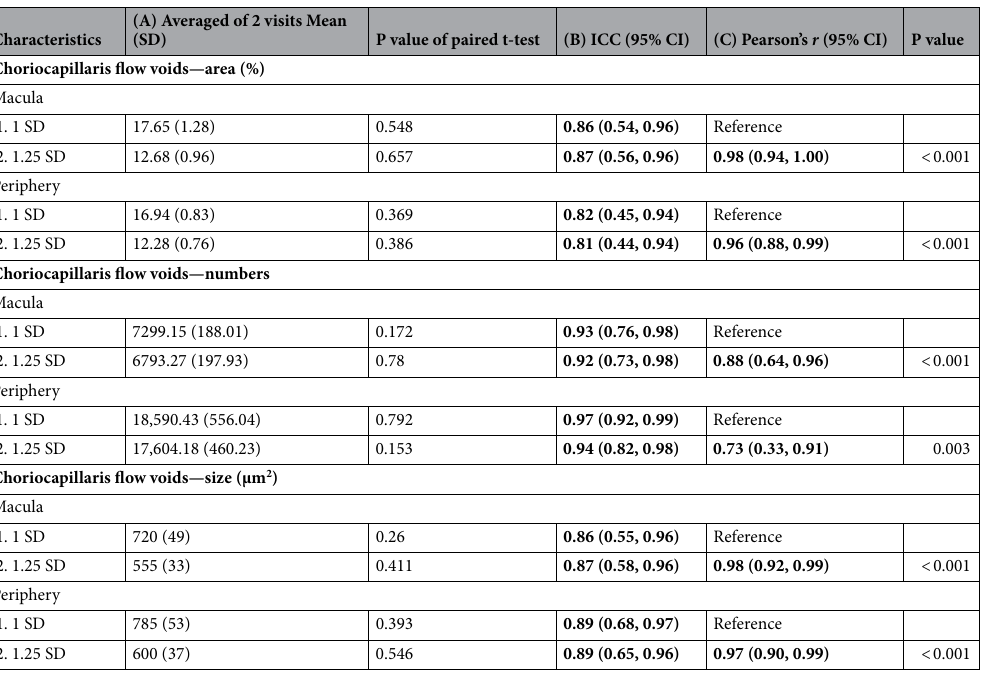
Table 2. OCTA vascular parameters of the choriocapillaris flow voids. Bold interface indicates the filter that provided good ICC (≥ 0.75) and P < 0.05 for Pearson’s correlation when compared to the 1SD thresholding strategy for each category. SD standard deviation; CI confidence interval; ICC intraclass correlation